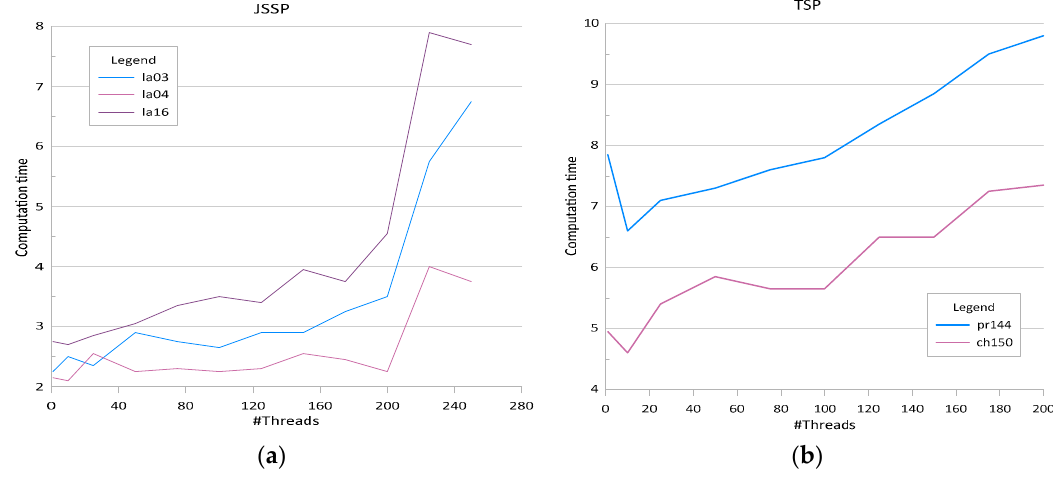
Figure 2. Mean computation time (s) versus the number of threads for some example ( a ) TSP and ( b ) JSSP datasets.